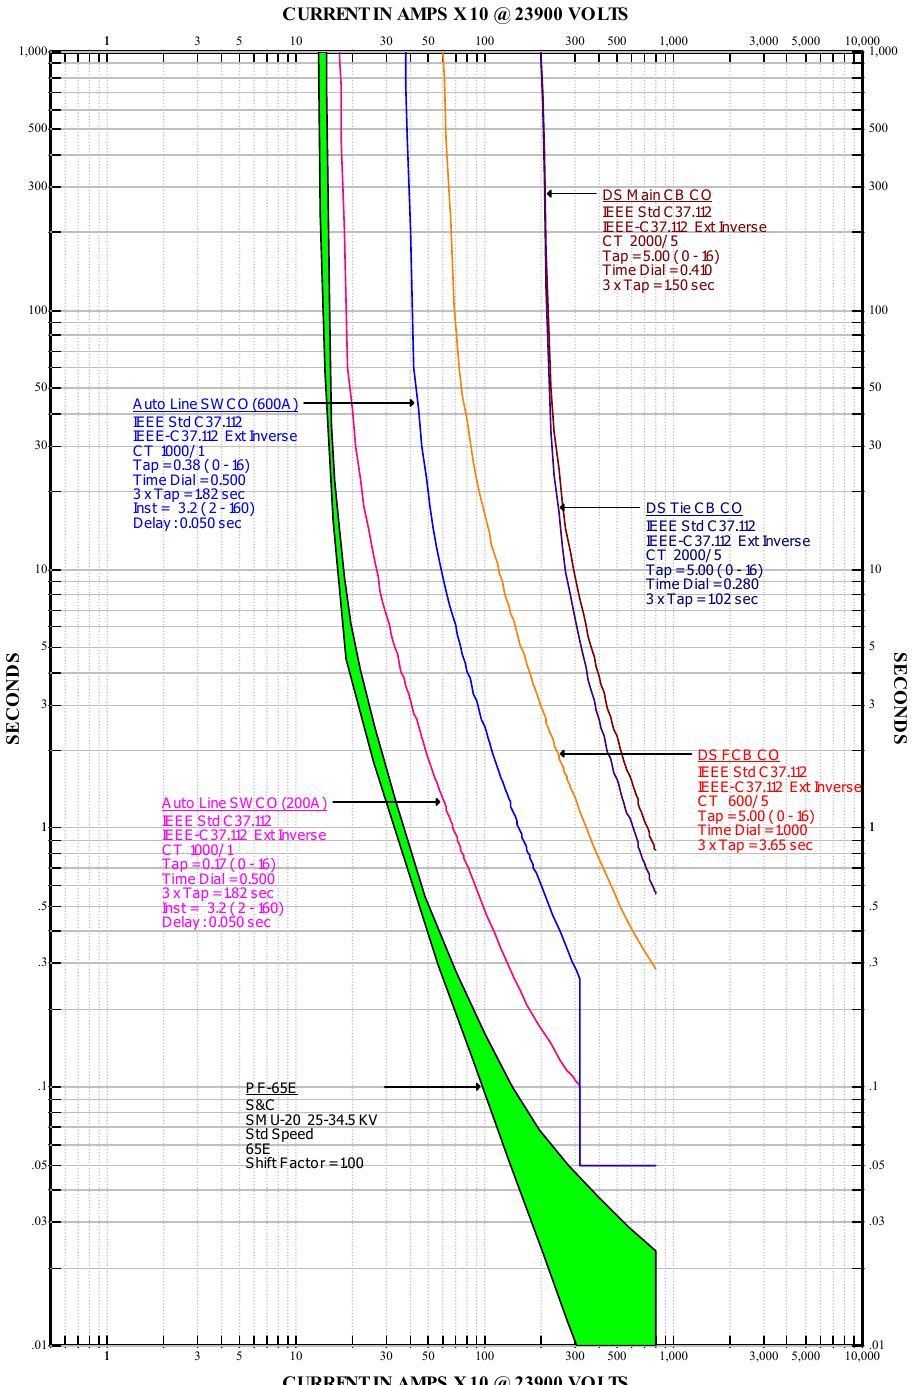
Figure 7. Proposed CO relays of Minsheng